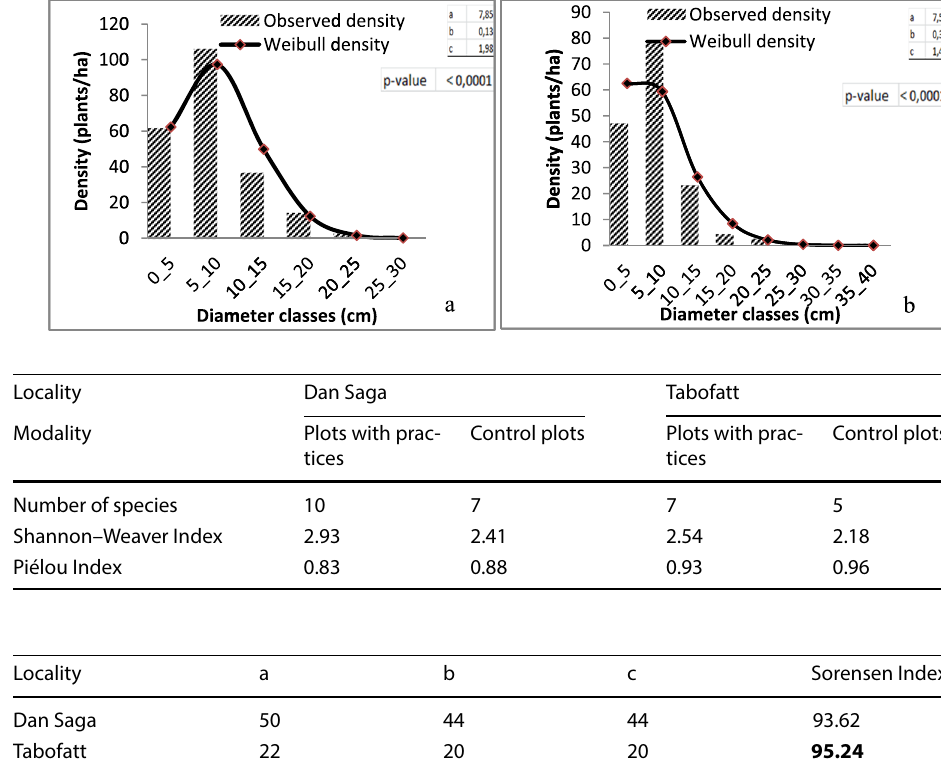
Fig. 3 Structure in diameter class of the woody population of the Tabofatt cluster (a case of plots with practice and b case of control plots)